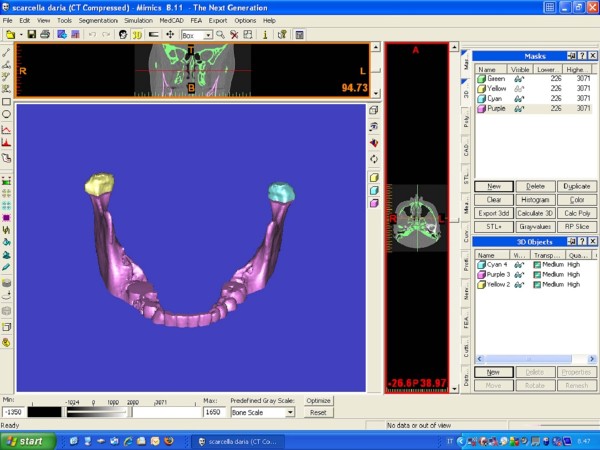
Condylar 3-D reconstructions with Mimics software. A mask which includes all mandibular bone structures is created with the Mimics software; the proper threshold for the grey scale is selected to identify the condylar area (1350–1650, in the line under the figure). The black boxes in the upper part of figures and on its right identify the exact position of the two condylar heads on the horizontal plane to define: (i) their antero-posterior distances respect to the frontal plane, and (ii) their right-left distances respect to the sagittal plane.